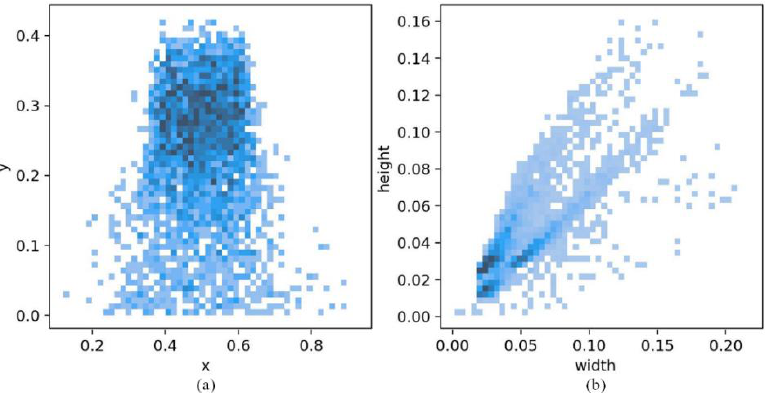
Figure 19. The annotated information of the synthetic dataset. ( a ) The coordinates of the center point of the annotation box; ( b ) the size of the annotation box.